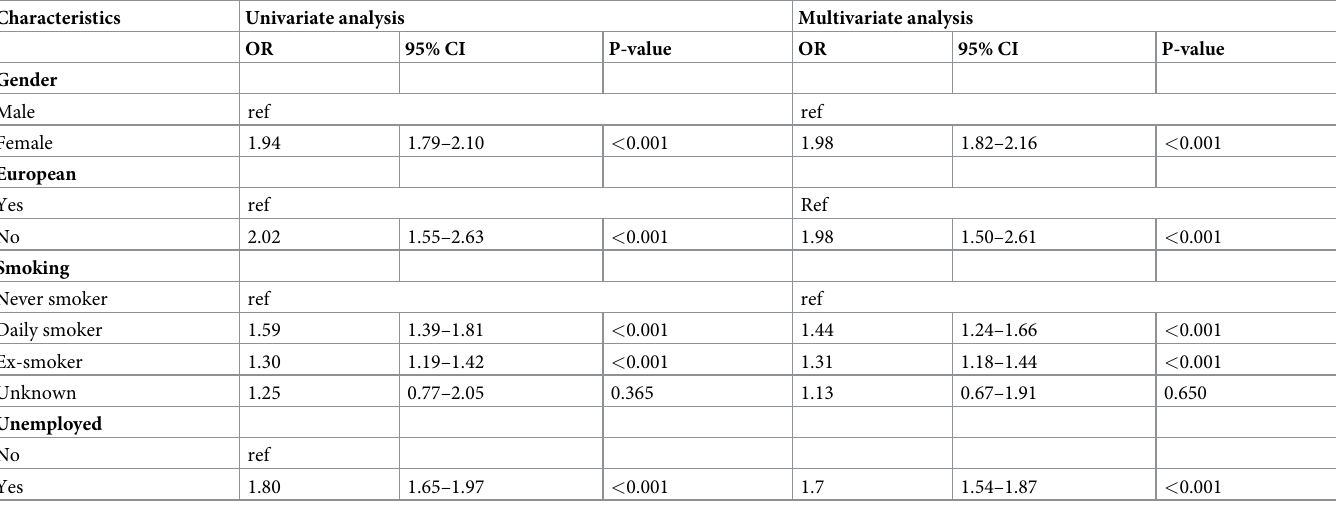
Table 3. Table showing odds ratio (OR) of fear for different variables of interest.